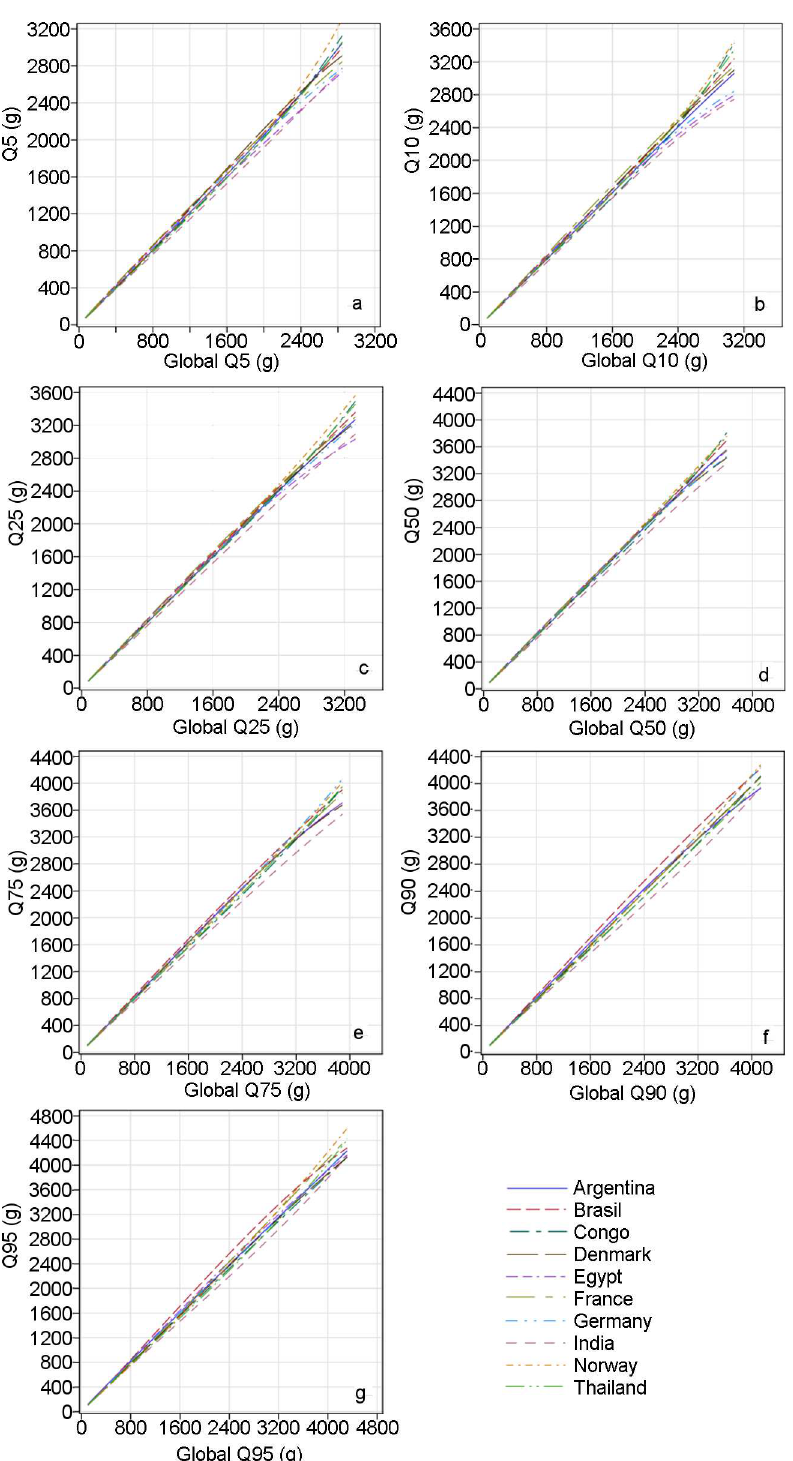
Fig 4. Quantile–quantile plots comparing countries’ distributions with the global distribution of estimatedfetal weight. The 5th, 10th, 25th, 50th, 75th, 90th, and 95th percentiles(Q05, Q10, Q25, Q50, Q75, and Q90, respectively) for the distributionof each country are plotted versus the same percentilesof the globaldistribution (globalQ05, globalQ10, globalQ25, globalQ50, globalQ75, globalQ90, respectively). Congo, Democratic Republicof the